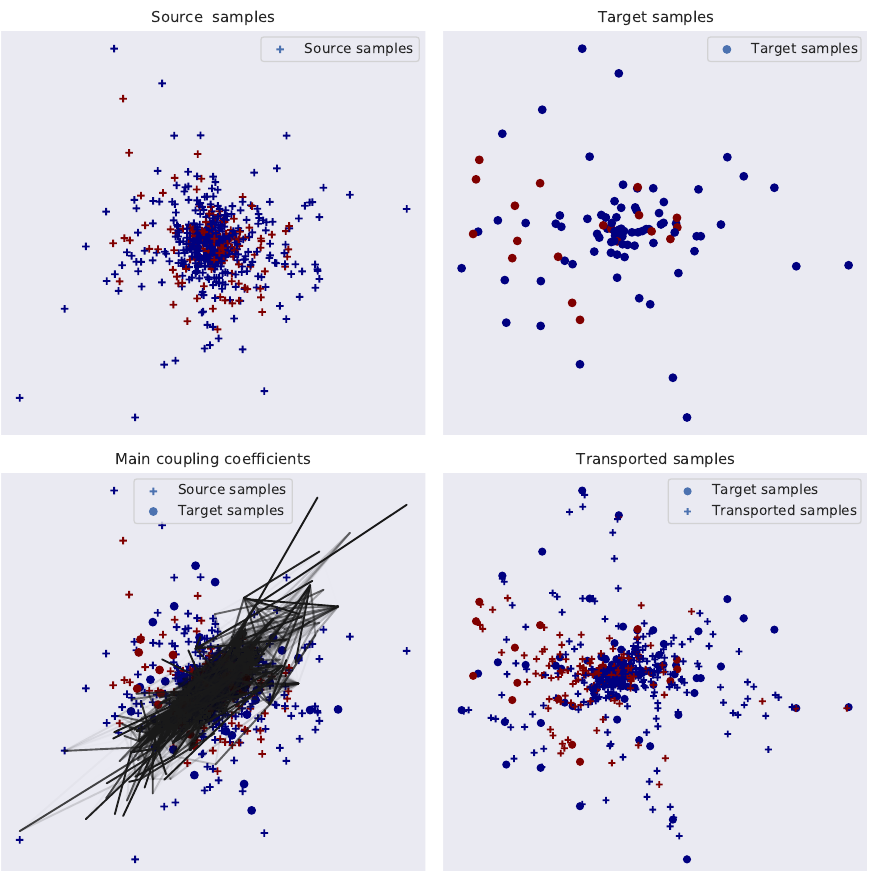
Figure 6. An illustration describing the transport of the probability distribution from the source domain to the target domain. The transport mapping in this example is obtained from Subject 5 of the FES group for the first and last features of the feature vector. The top two panels show the distribution of the source and target domains, followed by a probabilistic coupling between the two domains (bottom-left panel), and finally in the bottom-right panel, the distribution of transported sources is mapped together with the targets. The ‘+’ and ‘o’ mark the source (original and transported) and target samples, and the red and blue markers represent features associated with incorrect and correct trials,